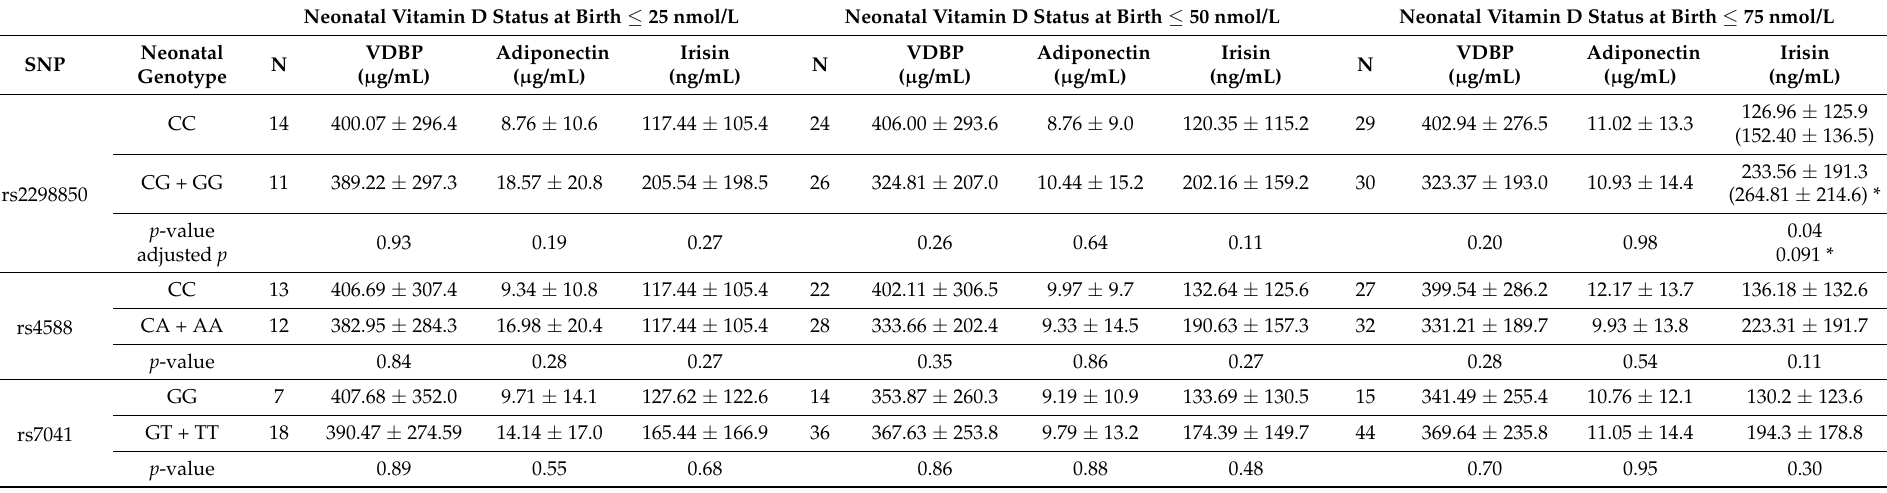
Table 3. Neonatal serum biomarkers according to neonatal vitamin D status at birth and neonatal VDBP polymorphisms. Neonatal Vitamin D Status at Birth ≤ 25